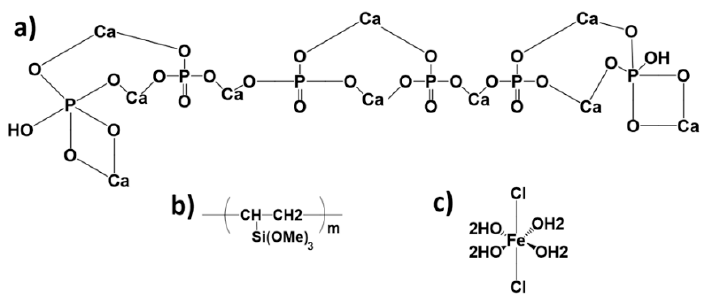
Figure 1. The chemical structures of the composite components ( a ) HA, ( b ) PVTMS and ( c ) Cl 2 FeH 8 O 4 .